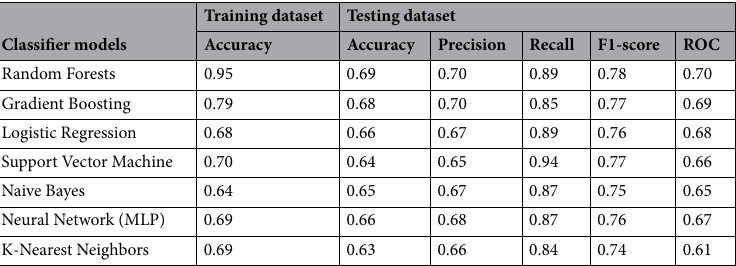
Table 2. Performance of each classifier model on training and testing dataset on the top 225